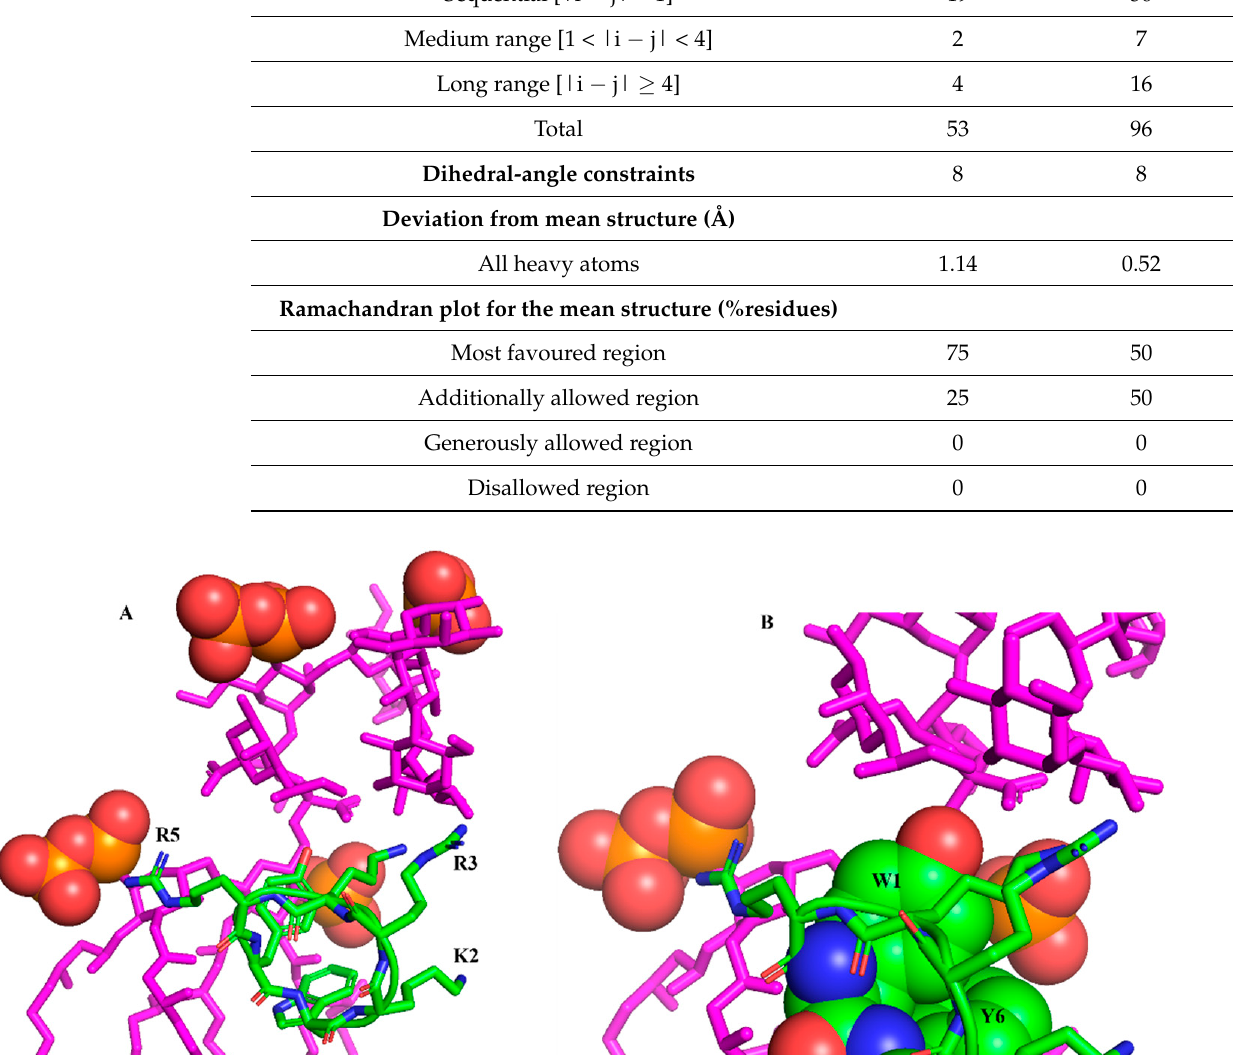
interactions. The sidechains of cationic residues R5, R3 and K2 of cWY6 are in proximity to The sidechains of cationic residues R5, R3 and K2 of cWY6 are in proximity to negatively charged